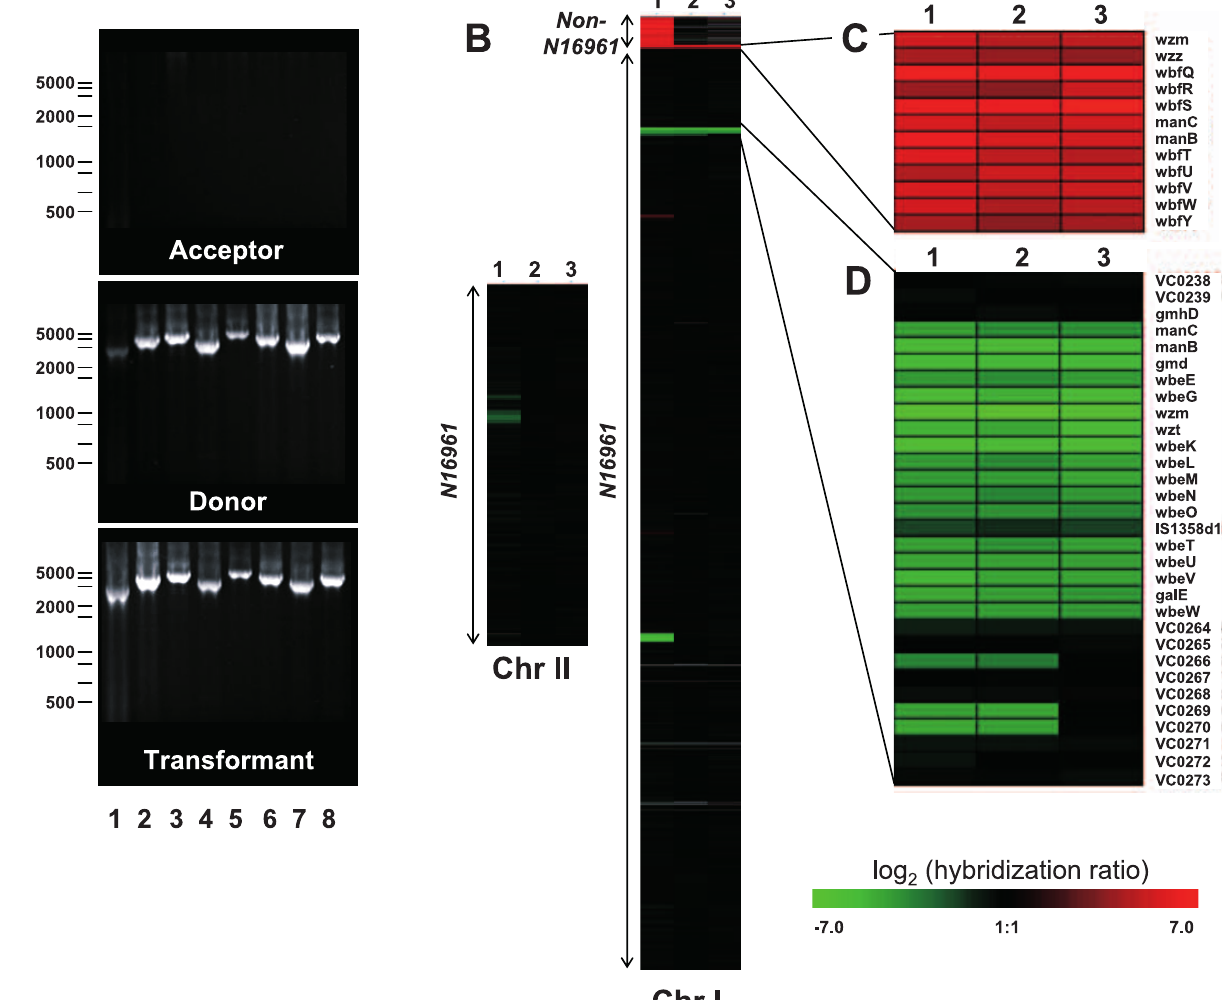
Figure 2. PCR and CGH Studies of Donor and Transformant gDNA Show Exchange of O-Antigen–Encoding Gene Clusters (A) gDNA from acceptor strain A1552 (O1), donor strain VCO139-Kan (O139 with Kan R marker), and a representative transformant were used as template in a PCR experiment. Lanes: PCR fragments 1 to 8 spanning the whole O139-antigen–encoding region according to Figure 1. (B) CGH data. CGH was used to compare genes present in the V. cholerae O1 A1552 acceptor strain (labeled with Cy3) with genes absent/present in the donor strain VCO139-Kan (lane 1; labeled with Cy5) or two representative transformants of the acceptor strain (lanes 2 and 3; labeled with Cy5). Oligonucleotides corresponding to genes of the large chromosome (Chr I) and small chromosome (Chr II) of the sequenced strain N16961 [31] were spotted on the microarray (depicted as N16961) in addition to oligonucleotides derived from 12 O139-specific genes and from 82 genes corresponding to the SXT element (denoted as non-N16961; for details see Figure S5). (C and D) Close-up of the O139-antigen–specific genes (C) and of the O1-antigen–specific gene cluster